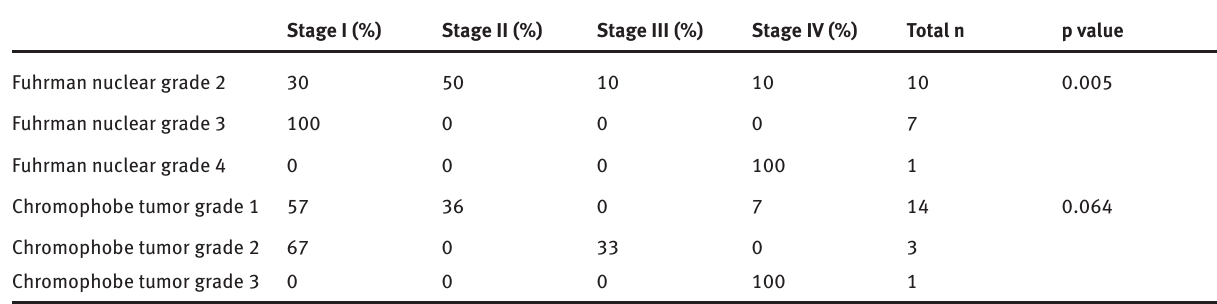
Table 3: Associations between TNM stage and nuclear grade